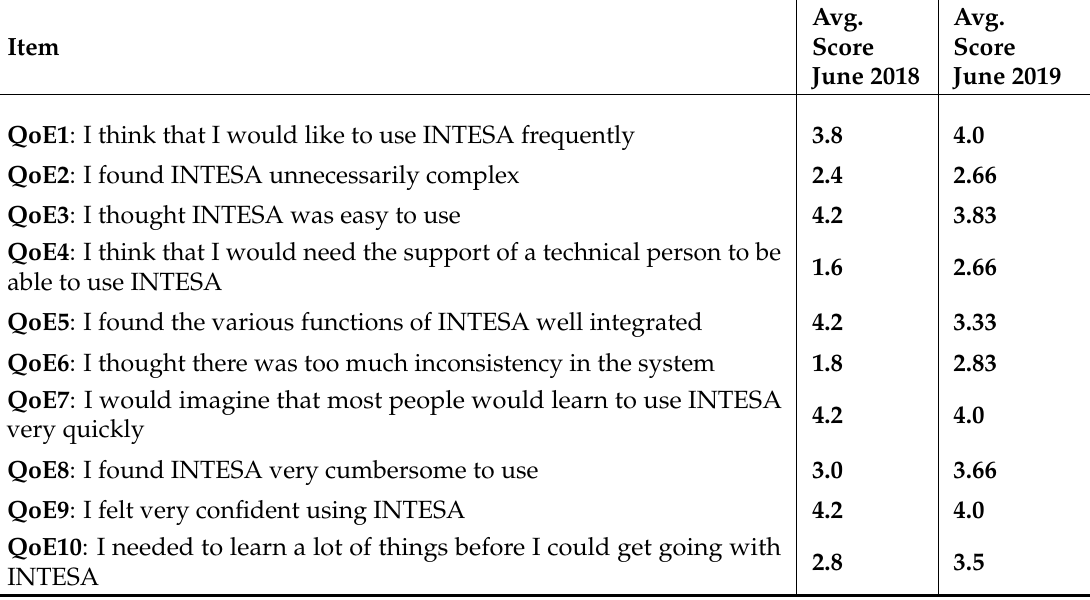
Table 6. Quality of experience (secondary